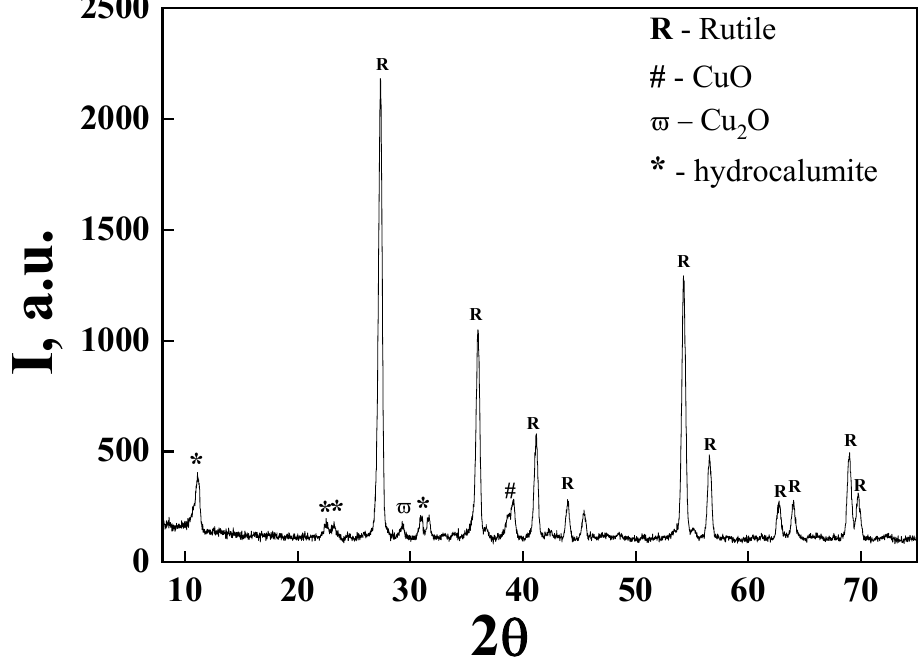
Figure 4. X-ray diffractogram of the S2 (Ca-Cu/TiO 2 ) sample.